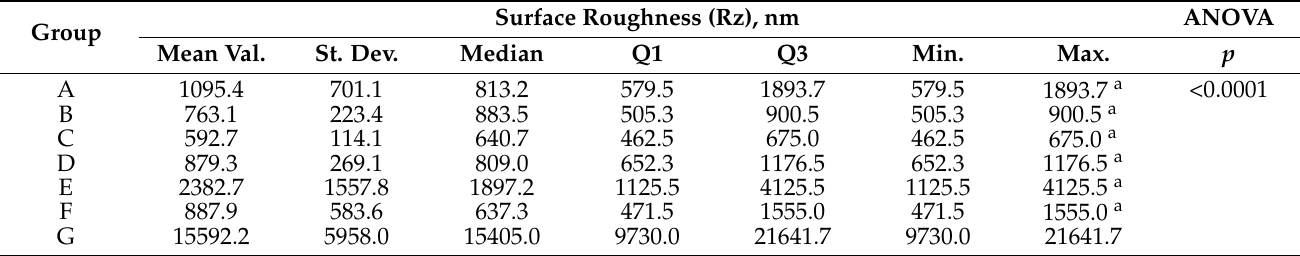
Table 5. Comparison of the roughness (Rz) between